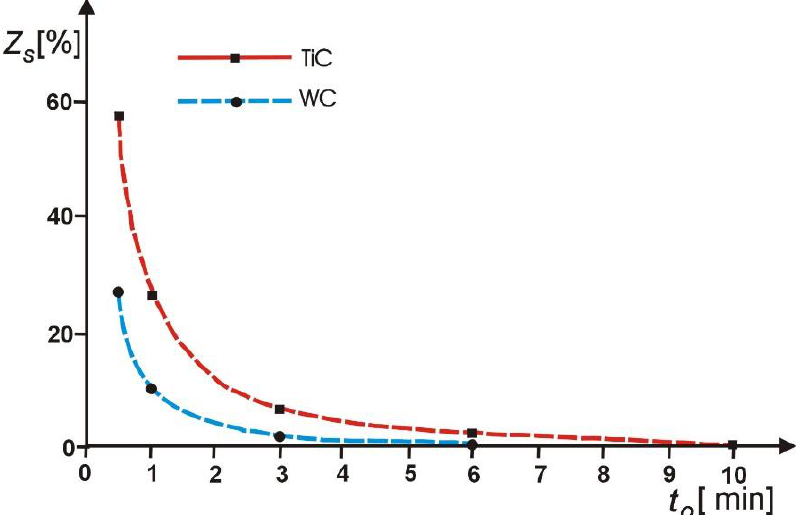
Figure 13. Effect of dressing time on the degree of gumming up products of cutting surface of superhard grinding wheel (CSGW).